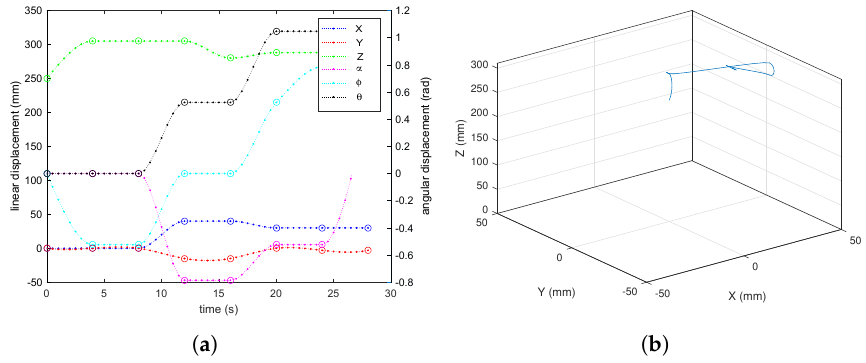
Figure 11. Bone surgery trajectory of Hybrid Mechanisms 1 and 2: ( a ) trajectory distribution and ( b ) 3D